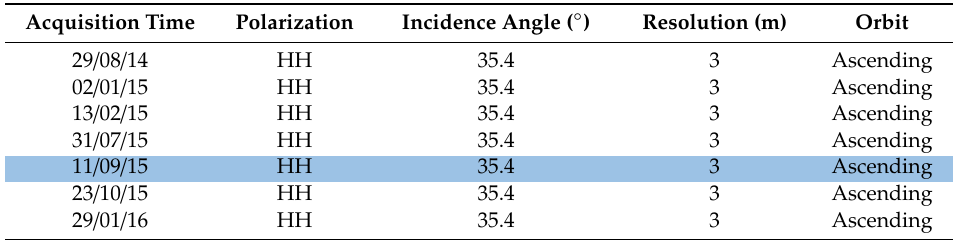
Table 3. ALOS-2 / PALSAR-2 intensity data used for the Joso case study (flood acquisition is marked in blue color).